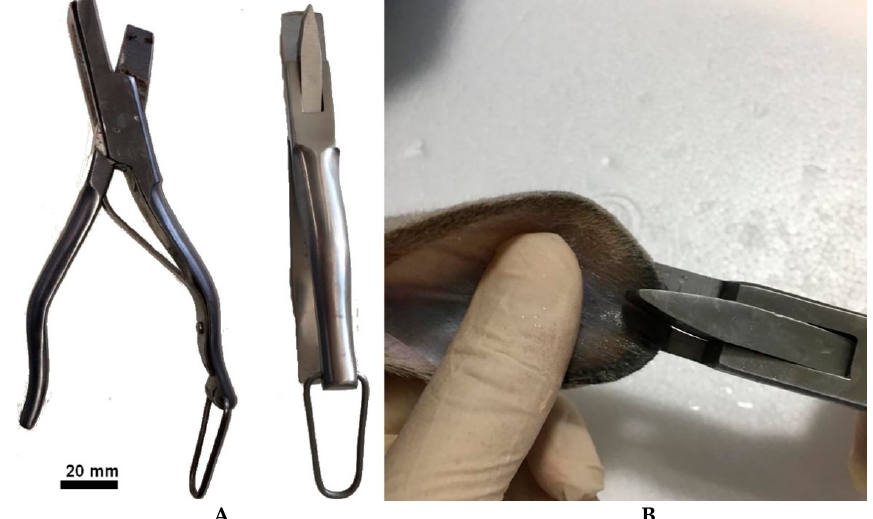
Figure 1. ( A ) Commercial equipment used for skin sample. ( B ) Collection of an ear